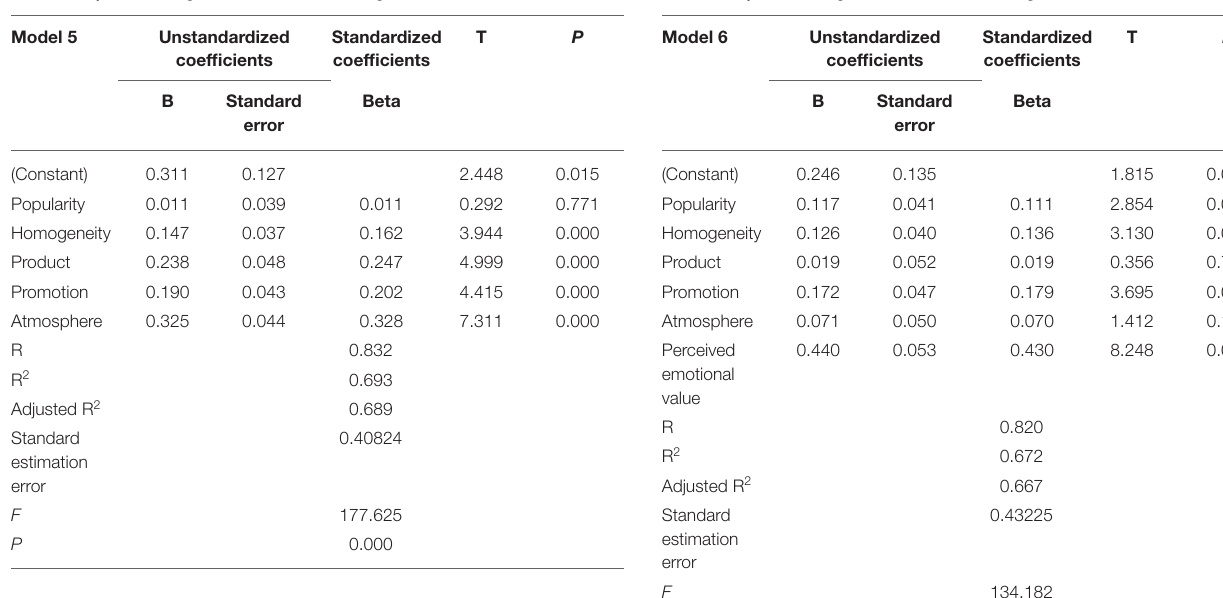
TABLE 13 | Model 5 regression coefficients and goodness-of-fit tests. TABLE 14 | Model 6 regression coefficients and goodness-of-fit